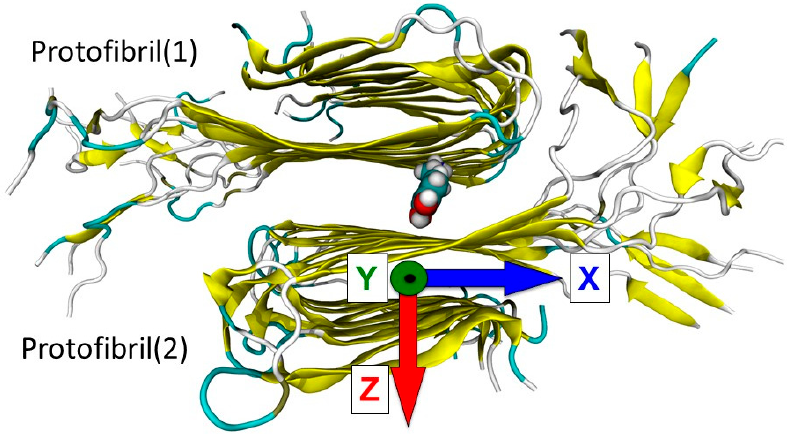
Figure 2. Pulling directions applied to protofibril (2) during the calculation of the forces needed for double-layered destruction: along the x-axis (i.e., outward shift of the protofibril (2) along its secondary axes), the y-axis (i.e., lateral shift of the protofibril (2) along its primary axes), and the z-axis (i.e., vertical shift, progressive removal of protofibril (2)).